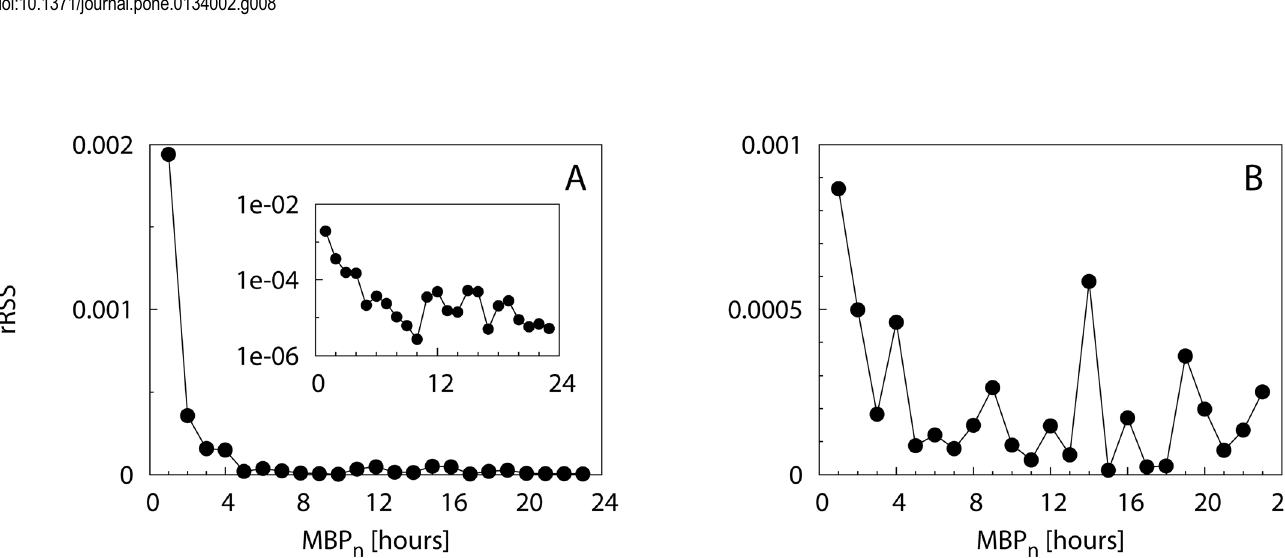
PLOS ONE | DOI:10.1371/journal.pone.0134002 August 11,